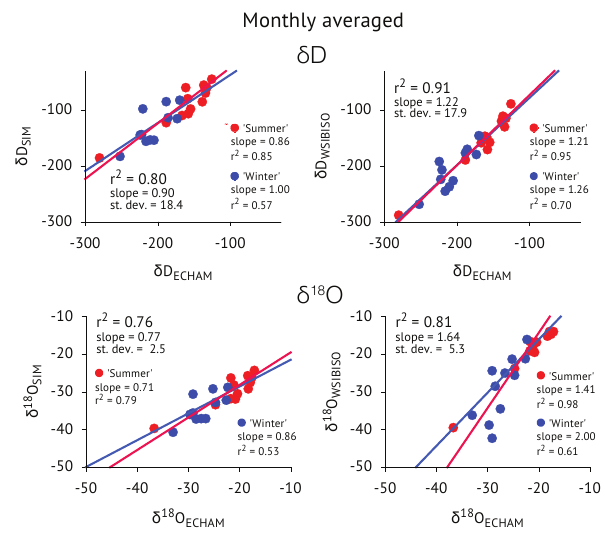
Figure 12. Left panels: correlation between ECHAM5-wiso model values and δ D and δ 18 O values calculated from the retrieved H 16 O using known relationships. Right panels: correlation between 2 ECHAM5-wiso model values and a posteriori calculated δ 18 O ( δ 18 O WSIBISO ) and δ D ( δ D WSIBISO ). “Summer” red points corre- spond to surface air temperatures above 15 ◦ C, “winter” blue points correspond to temperatures below 15 ◦